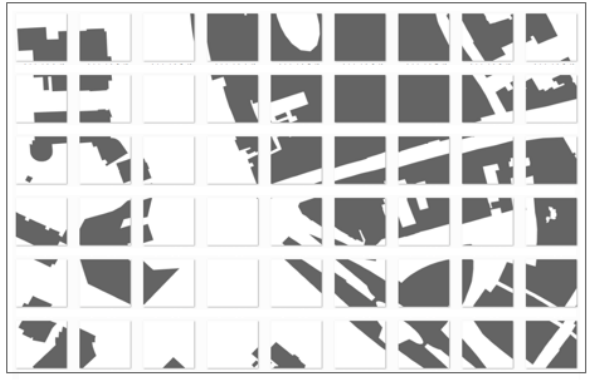
Figure 15. The ground